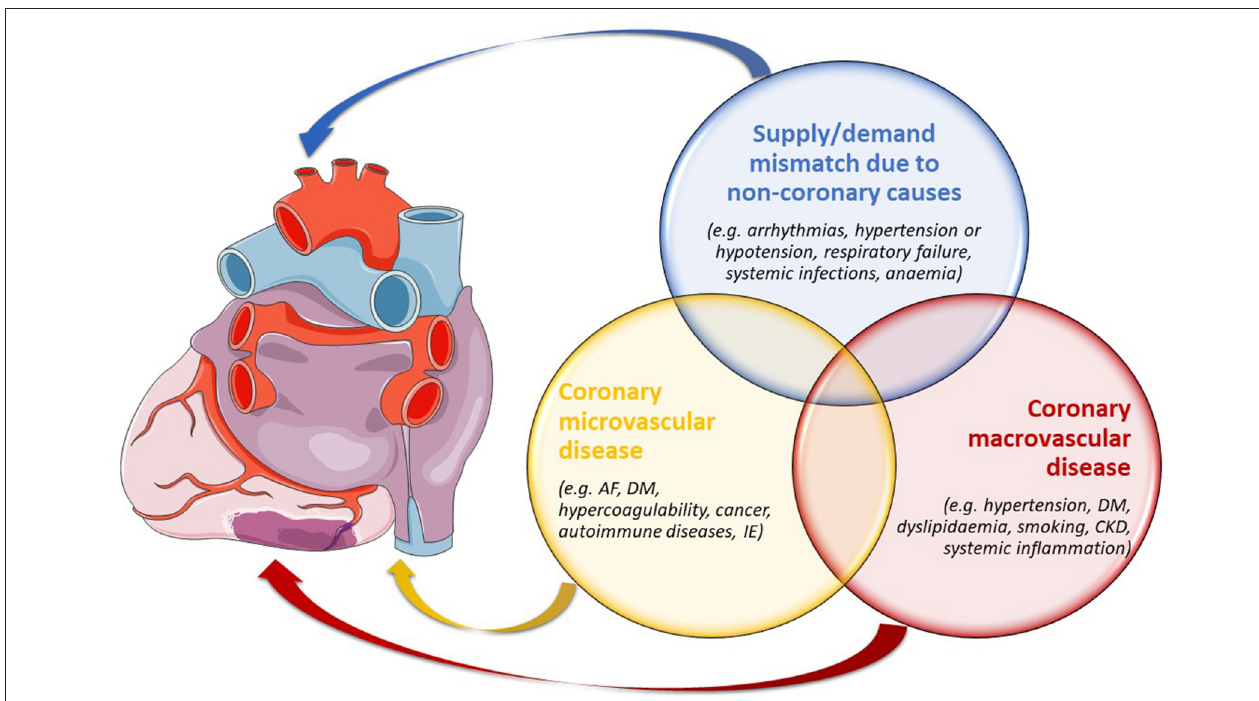
FIGURE 1 | The principal types of MINOCA as per aetiologies and pathogeneses, potentially overlapping between one another. AF, atrial fibrillation; CKD, chronic kidney disease; DM, diabetes mellitus; IE, infective